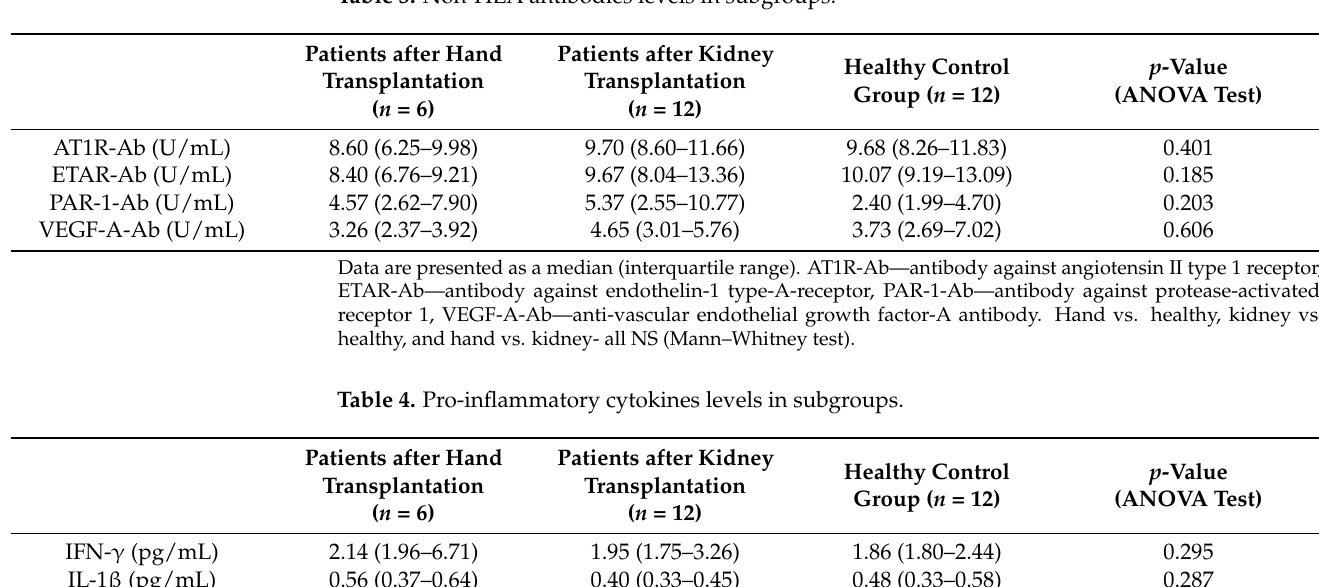
Table 3. Non-HLA antibodies levels in subgroups.